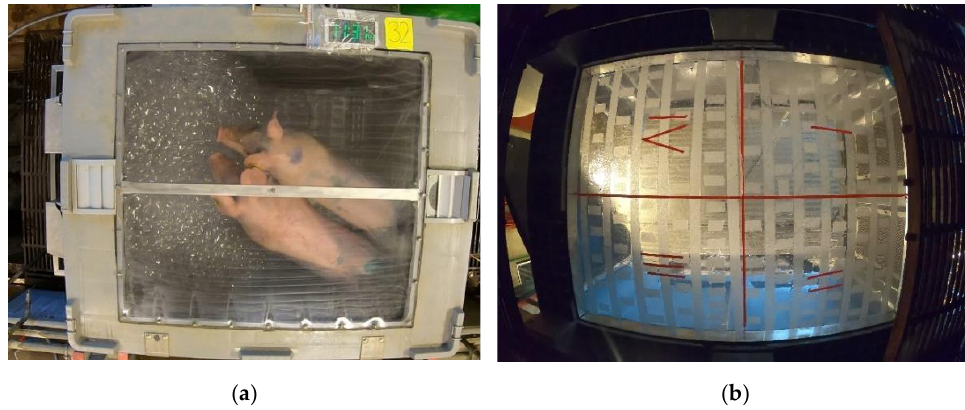
Figure 1. Camera angles used for recording pig behaviour through ( a ) the transparent lid and ( b ) the floor of the box, divided into four equal squares (I-IV) with coloured tape.